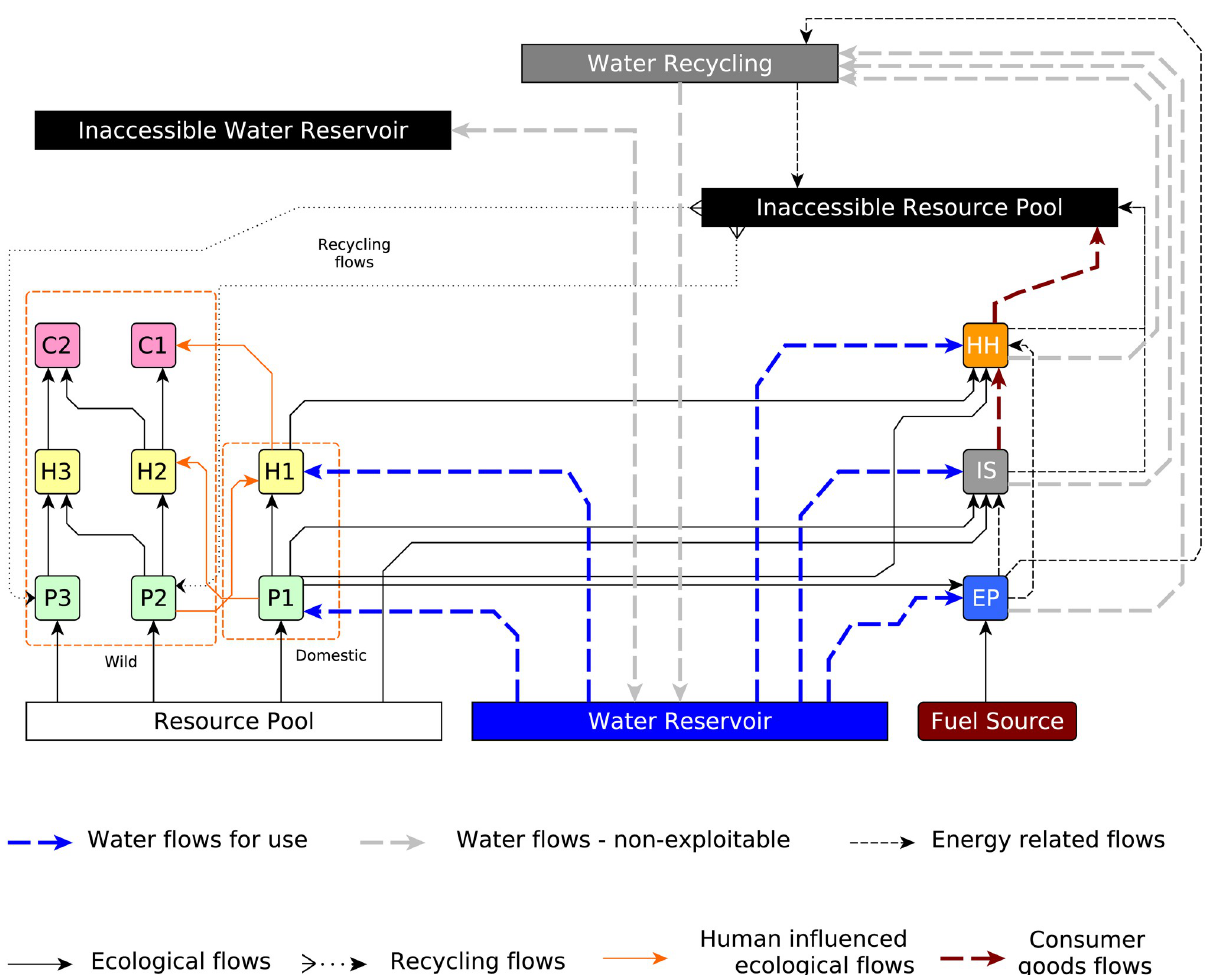
Fig 1. Generalized Global Sustainability Model (GGSM). Compartments: primary producers (P 1 ,P 2 ,P 3 ), herbivores (H 1 ,H 2 ,H 3 ), carnivores (C 1 , C 2 ), human households (HH), industry sector (IS), energy producer (EP), fuel source, water reservoir, resource pool, inaccessible resource pool.